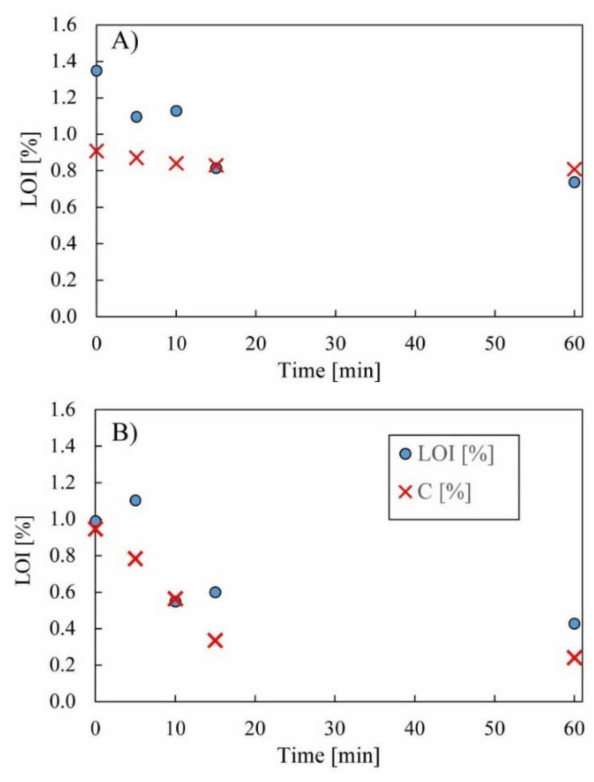
Figure 9. ( A ) Clean sands from stirring process, ( B ) clean sands from light